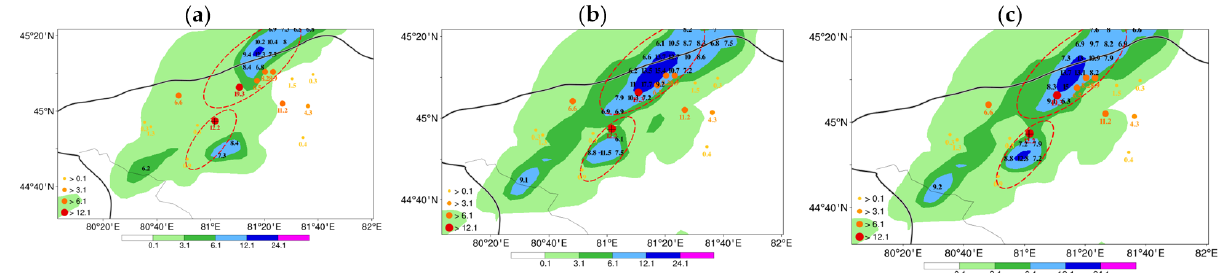
Figure 13. The increment and difference of precipitable water (PW, unit mm) and convective available potential energy (CAPE, unit J/kg) at 0800 UTC 30 July 2019. ( a ) The increment of PW from C2Rad. ( b ) The increment of PW from C2RadBy. ( c ) The difference of PW between ( a , b ). ( d ) The increment of CAPE from C2RadBy. ( e ) The increment of CAPE from C2RadBy. ( f ) The difference of CAPE between ( d , e ).